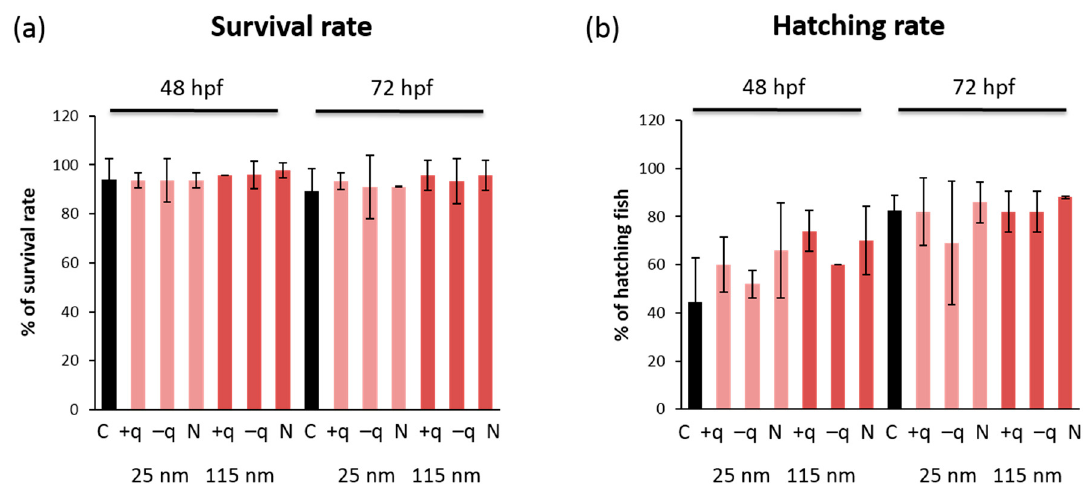
Figure 1. The effect of exposure to SiO 2 NPs on the development of zebrafish embryos. ( a ) Survival rate and ( b ) hatching rate after exposure to 100 mg/L of 25- or 115-nm SiO 2 NPs with different surface charges at 48 and 72 hpf. Data are represented as mean ± SD (standard deviation).